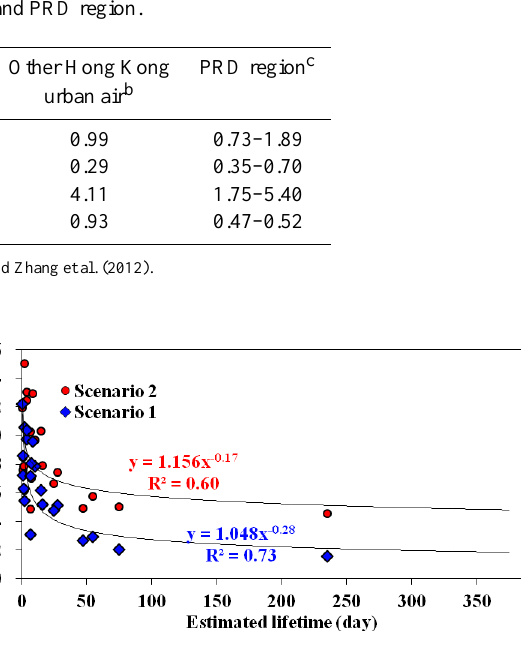
Fig. 7. Scatter plots of (a) CO and (b) SO 2 during daytime and nighttime hours between TMS and TW.